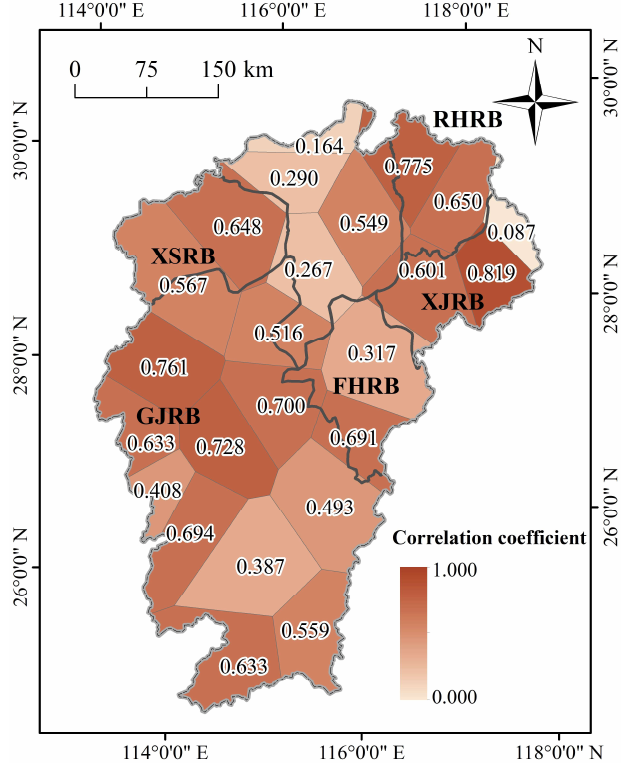
Figure 10. Correlation coefficients between groundwater level and precipitation in the PLB.